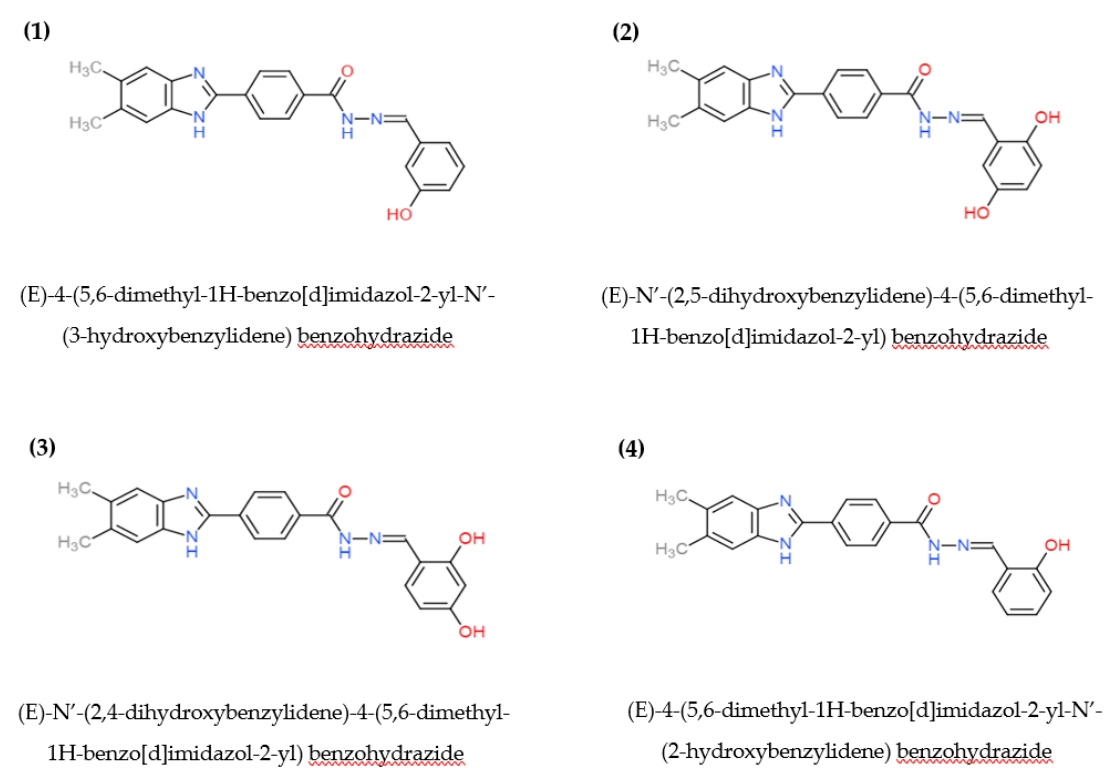
Figure 2. Chemical structure of benzimidazole derivatives.